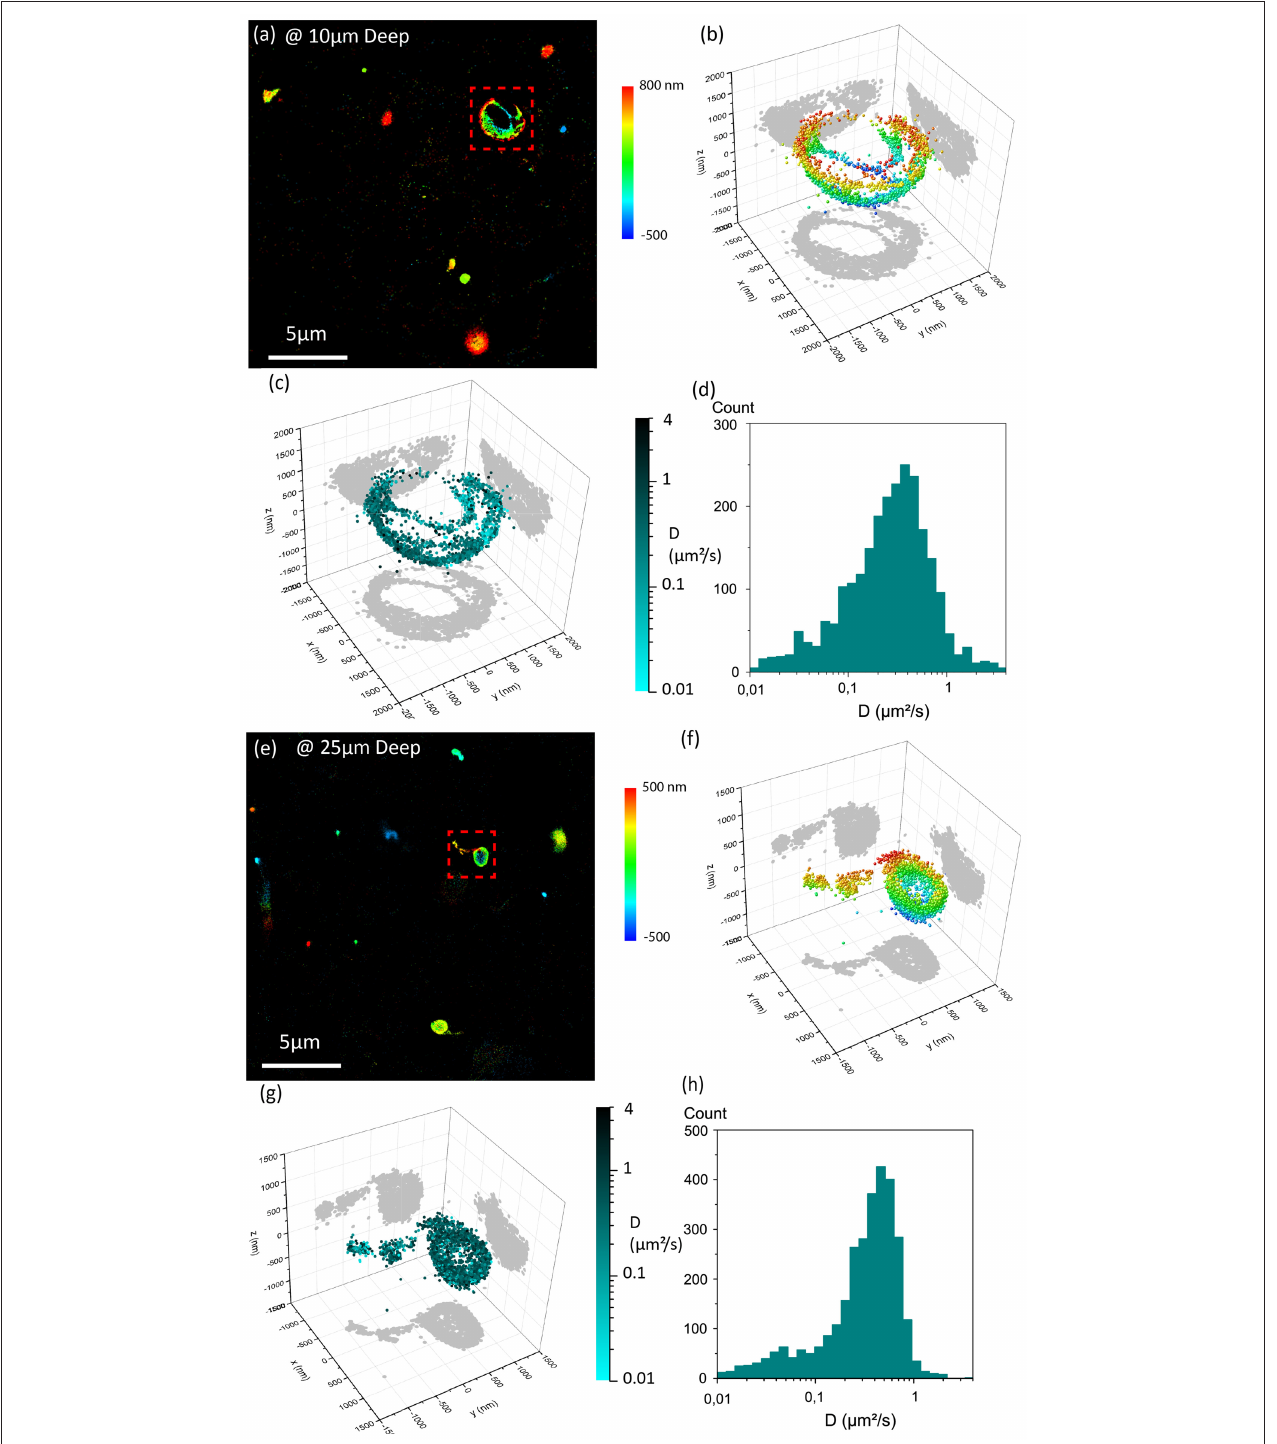
FIGURE 4 | Single fluorescent QDot tracking in live organotypic brain slices. (a–d) Depth of imaging is 10 µ m. (e–h) and 25 µ m. (a,e) Super-resolved 3D trajectories of single QDots. (b,f) Selected trajectories (with 2D projection) within the red doted square region in (a,e) the color coding corresponds to the axial positions. (c,g) Same as (b,f) the color coding corresponds to the instantaneous diffusion coefficients along the trajectory in logarithmic scale. (d,h) Corresponding histograms of instantaneous diffusion coefficients along the considered trajectories (c,g) .